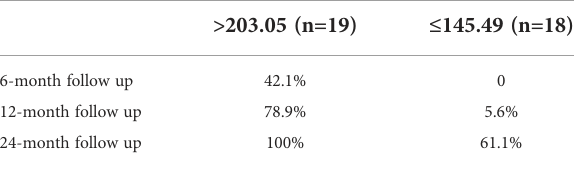
TABLE 4 Remission rates at different time points in IMN patients with baseline IL-35 (pg/ml) >203.05 and ≤